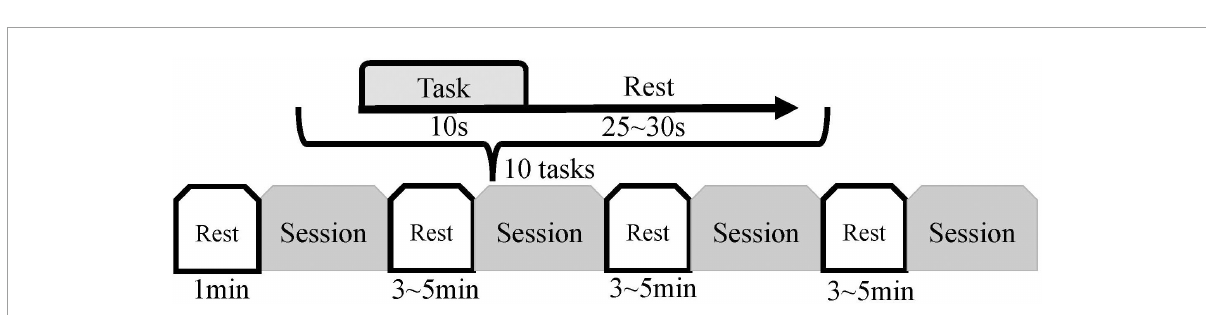
FIGURE2 Experimental procedure. Each subject was introduced to the experimental procedure and tried out the equipment before the formal experiment. Each subject had four sessions, each consisting of 10 experimental tasks; the sequence of the task types within the 10 experimental tasks was randomized (Rest, MV, MO, and MOV). The duration of each task was 10 s, with a rest period of 25–30 s between tasks. Subjects performed a 1-min resting state before the experiment and rested for 3–5 min after each